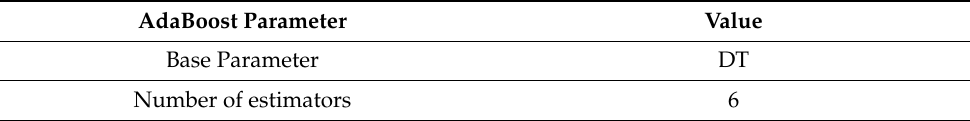
Table 6. The optimal parameters obtained by the AdaBoost